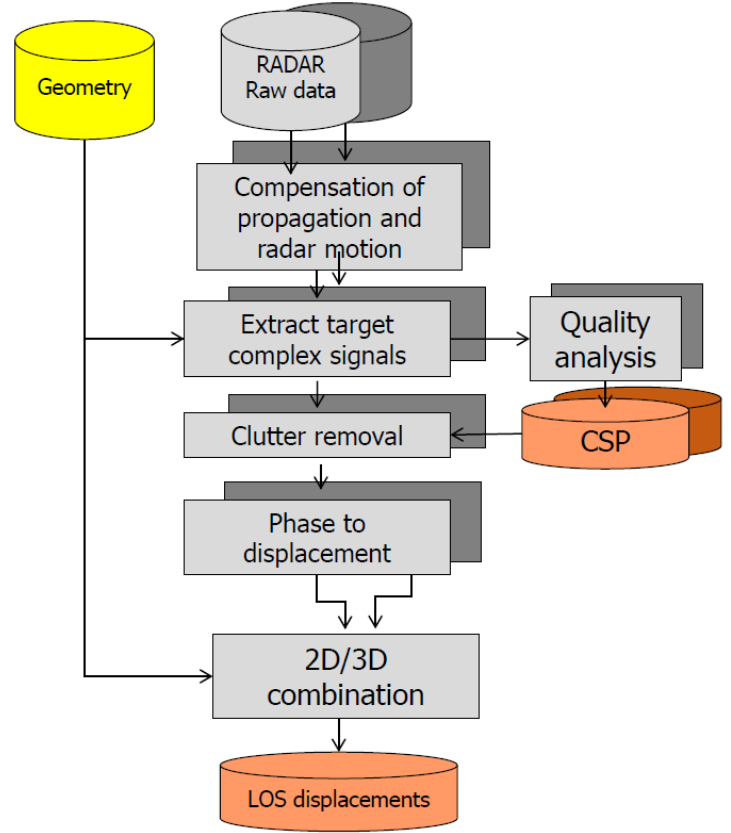
Figure 9. Schematic block diagram for the 2D/3D vibration estimation method herein proposed.